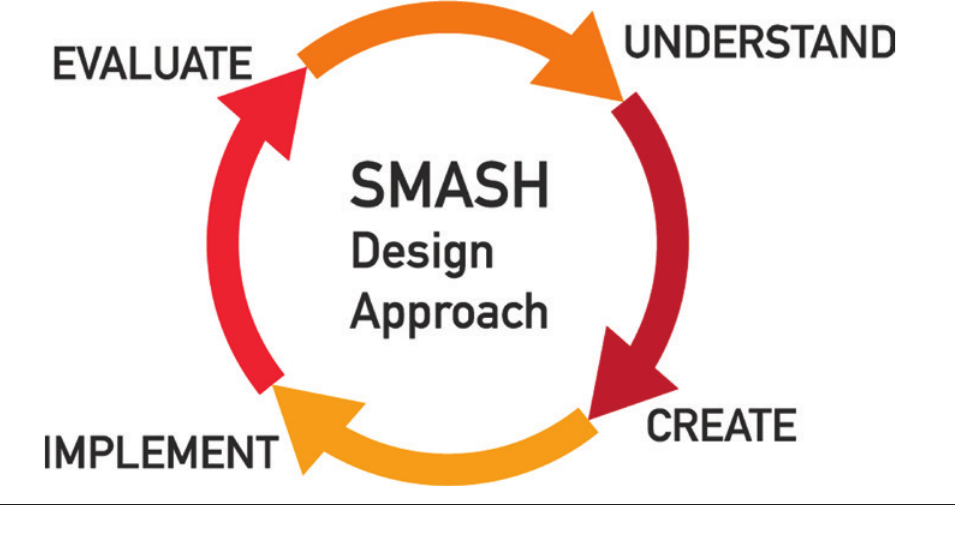
figure 2: Top-level co-design process (credit: authors)